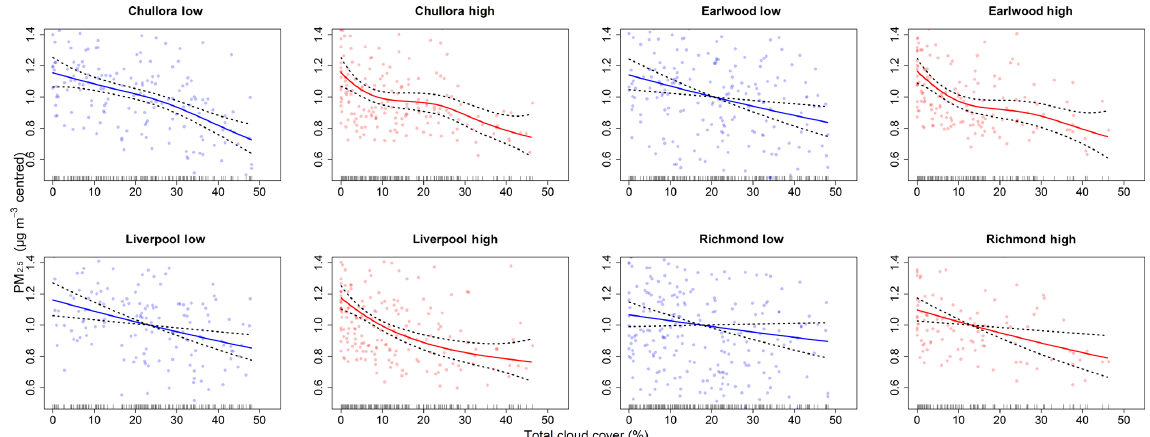
Figure 7. The contribution by the cloud cover component of the GAMM linear predictor to fitted PM 2 . 5 values (µgm − 3 , centred). The solid lines are the fitted curves. Dotted lines are 95% confidence bands. Dots are partial